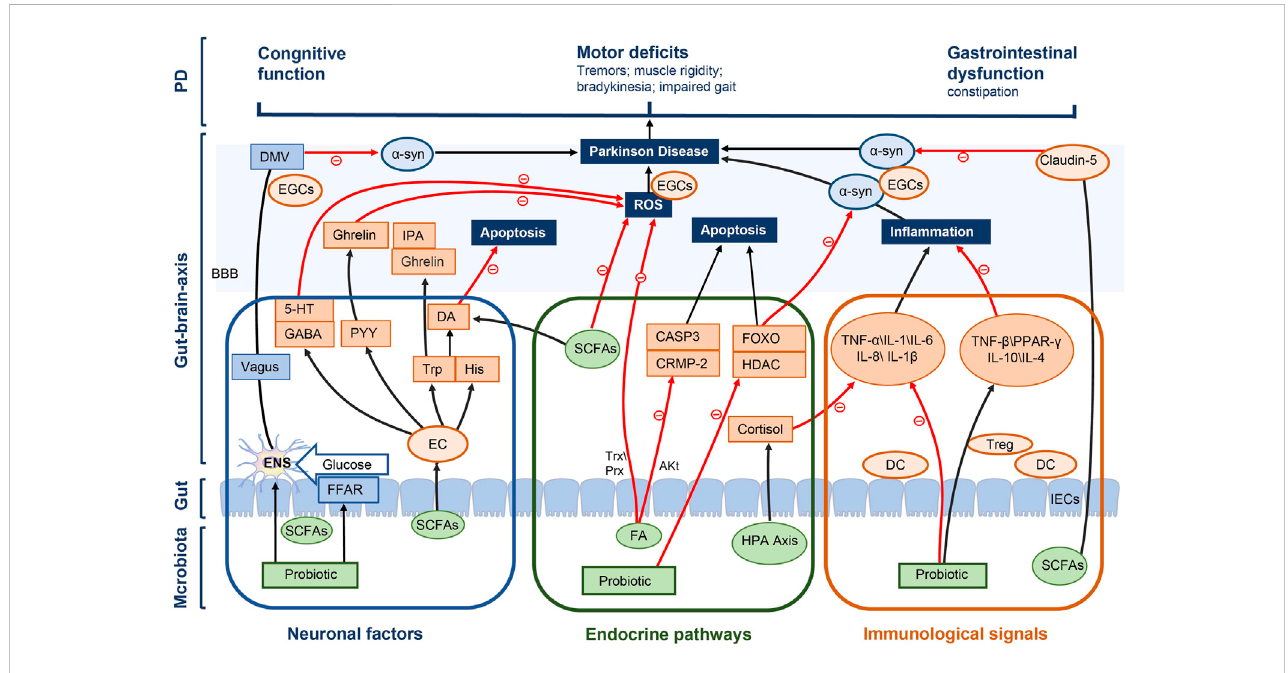
FIGURE 11 Potential mechanisms of the probiotic modulation in PD